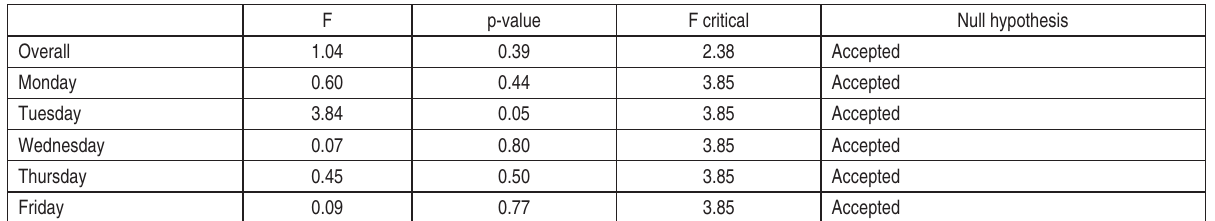
Table B4. ANOVA test of the day-of-the-week effect for PFTS